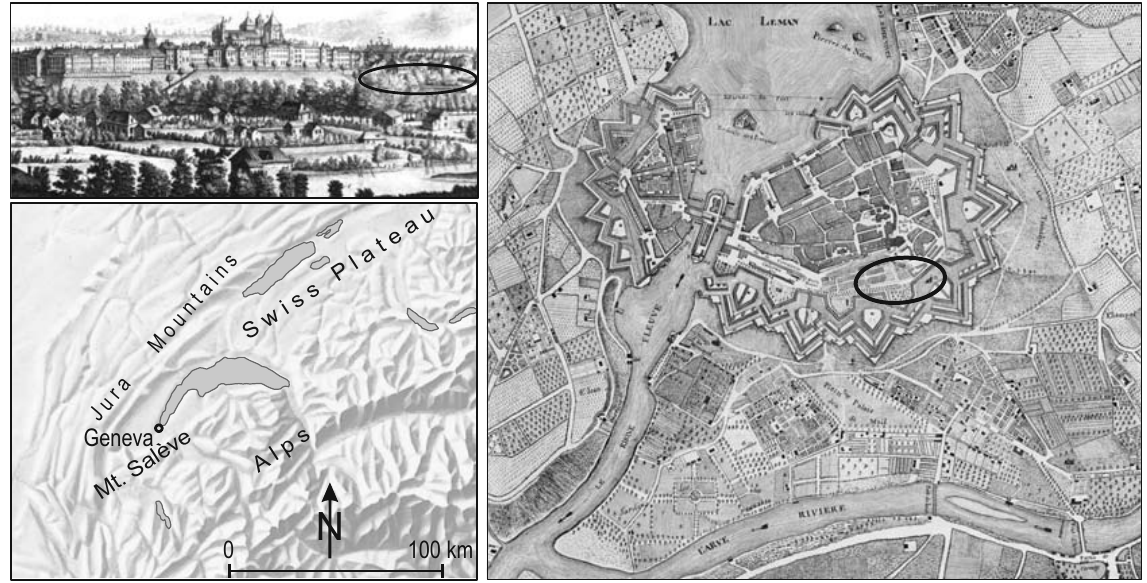
Fig. 1. Approximate location of the weather station of Geneva in 1799–1821 in a contemporary view (top left panel) and map (right panel) of the city. The bottom left panel shows the topography of the region (relief: Eidgen¨ossische